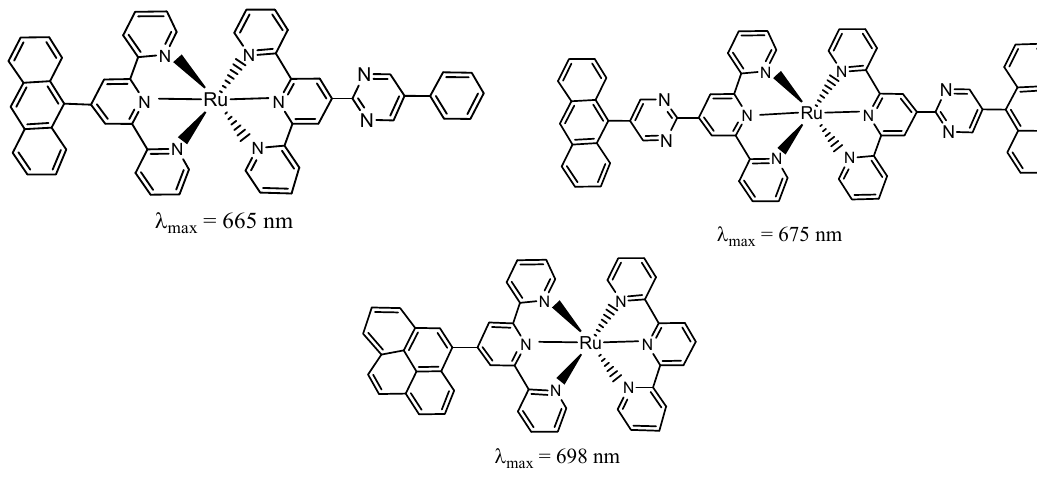
Figure 7. Structures of Ru(II) polypyridyl complexes with no anchoring